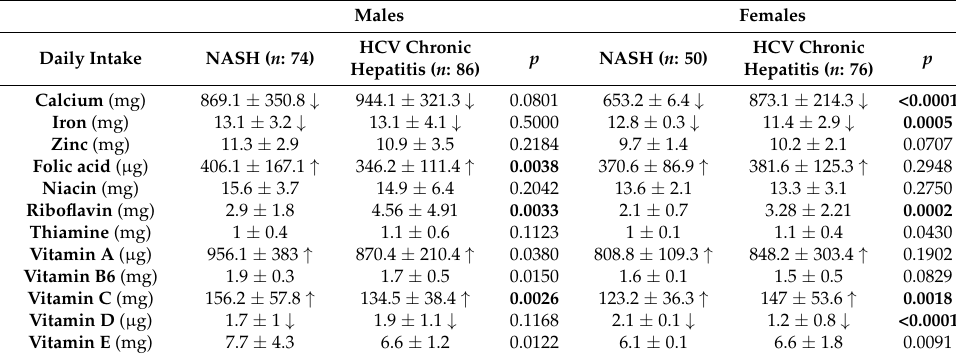
Table 7. Intake of micronutrients in study population in males and females (NASH versus HCV-chronic hepatitis (Mean ±